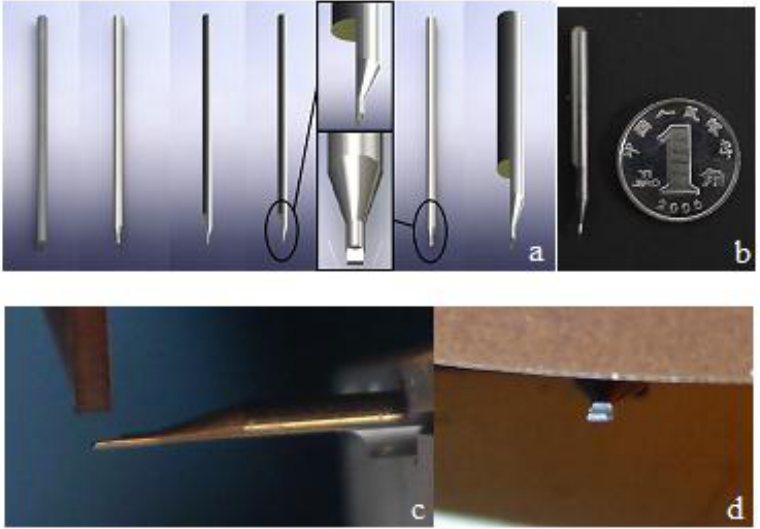
Figure 2. Fabricating of a rectangle microscriber. ( a ) Fabrication process of a rectangle microscriber; ( b ) A rectangle microscriber after fabrication; ( c ) A rectangle microscriber